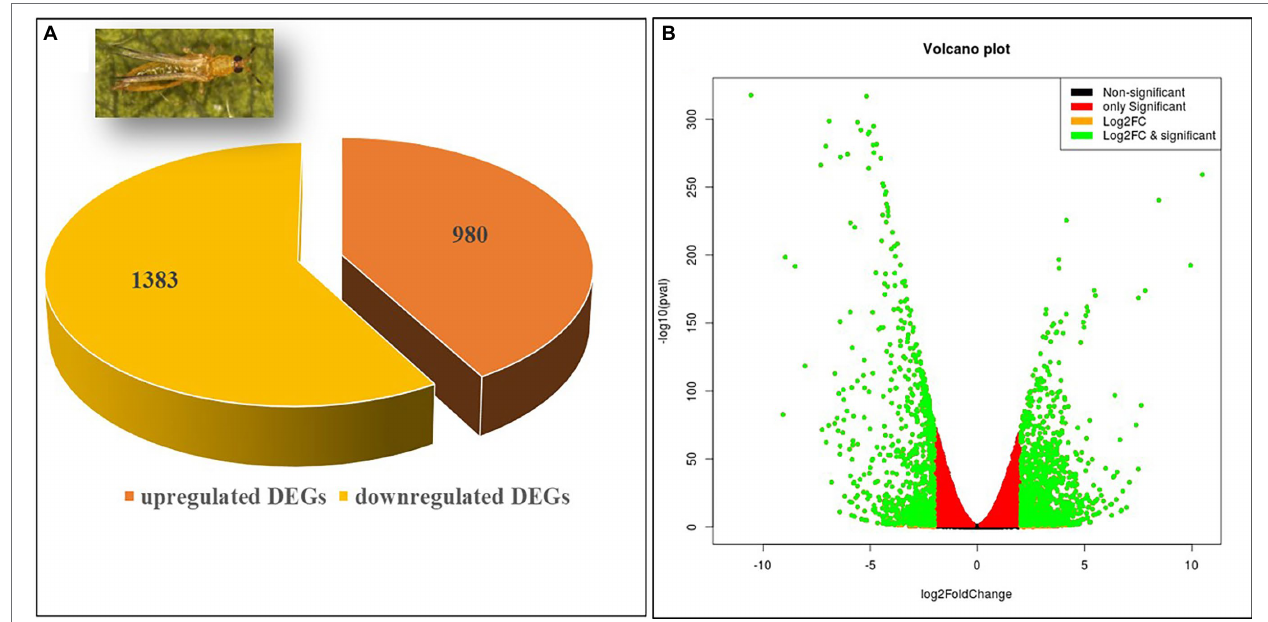
FIGURE 1 | The proportion of differentially expressed genes (DEGs) in RNA-Seq analysis. (A) A total of 1,383 DEGs were found upregulated while 980 were downregulated. (B) Volcano plot of DEGs. The x axis shows the fold change in gene expression between different samples, and the y axis shows the statistical significance of the differences. Significantly up- and downregulated genes with log 2 FC ≥ 2 are highlighted in green. The black dots represent insignificant differentially expressed